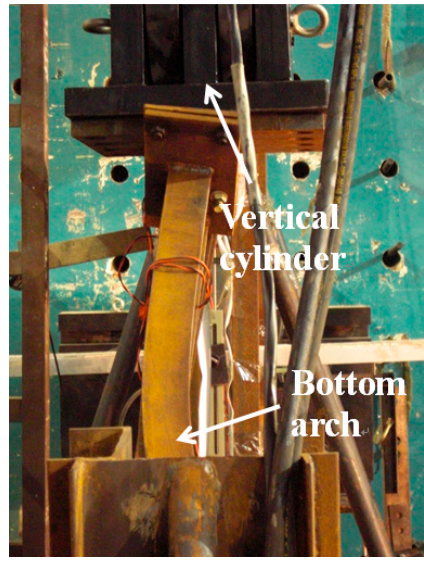
Figure 11. Bottom arch in model 4 after loading.